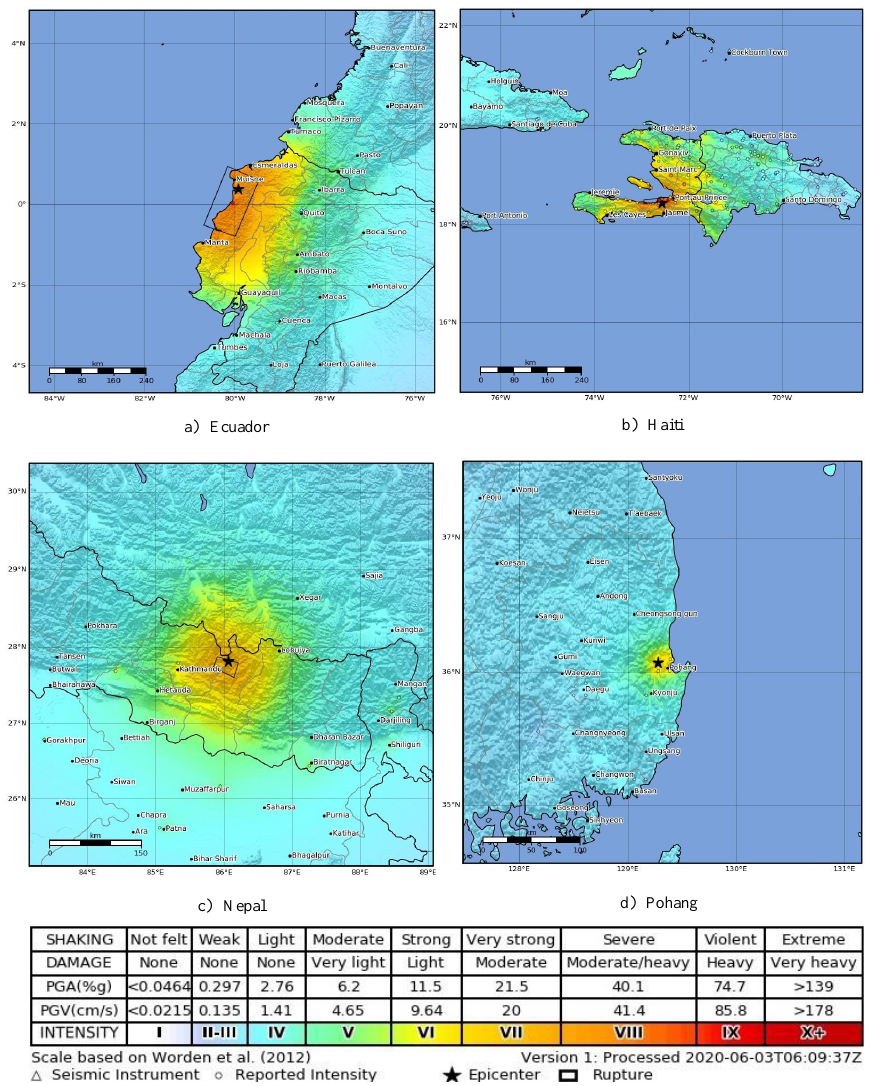
Figure 1. ShakeMap and intensity scale for the ( a ) Ecuador; ( b ) Haiti; ( c ) Nepal; and ( d ) Pohang Earthquake